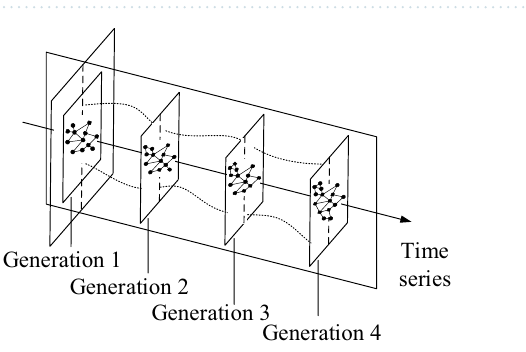
Figure 2. Structural network of a single product entity. (Adapted in part with free permission from iFixit, https:// www. ifixit. com/ Teard own/ iPhone+ 12+ and+ 12+ Pro+ Teard own/ 137669. Licenced under the CC BY open access licence).